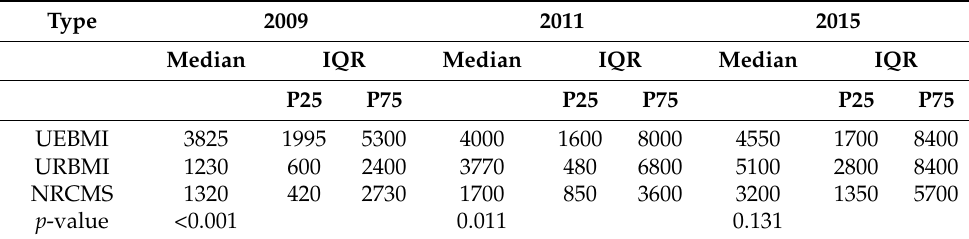
Table 5. Inpatient reimbursement amount by year and social health insurance schemes in China